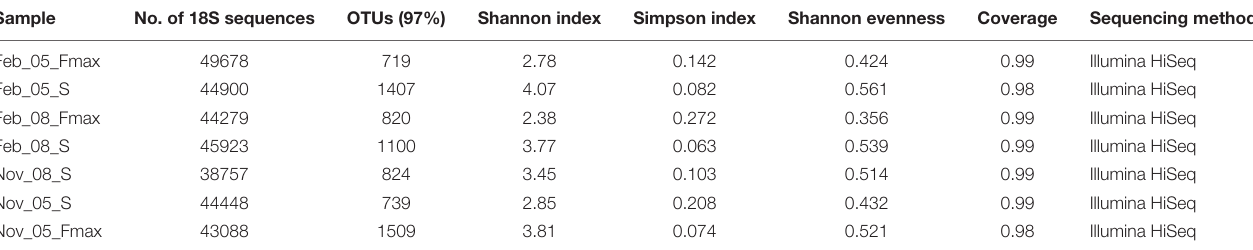
TABLE 3 | Number of 18S sequences obtained in samples collected from stations 5 and 8 on the St Helena Bay Monitoring Line in November 2015 and February 2016. Sample No. of 18S sequences OTUs (97%) Shannon index